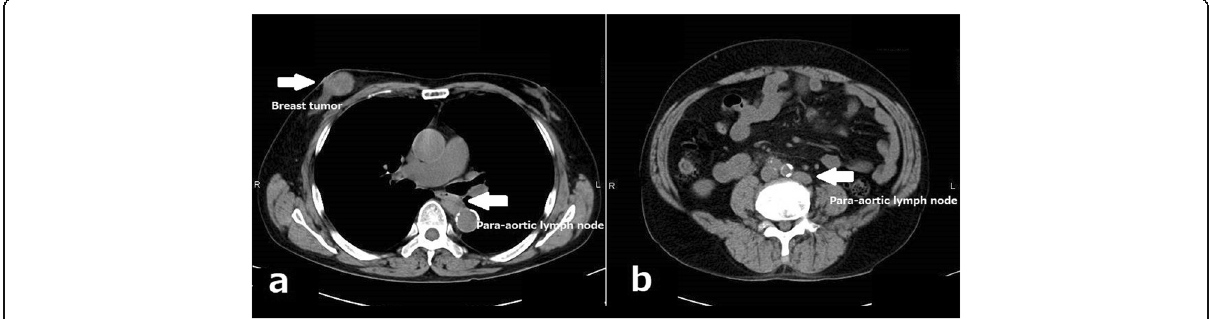
Fig. 2 Chest and abdominal computed tomography. Legend: Computed tomography showed the right breast tumor ( a ) and the para-aortic lymph nodes enlargement which had not changed for several months ( a , b